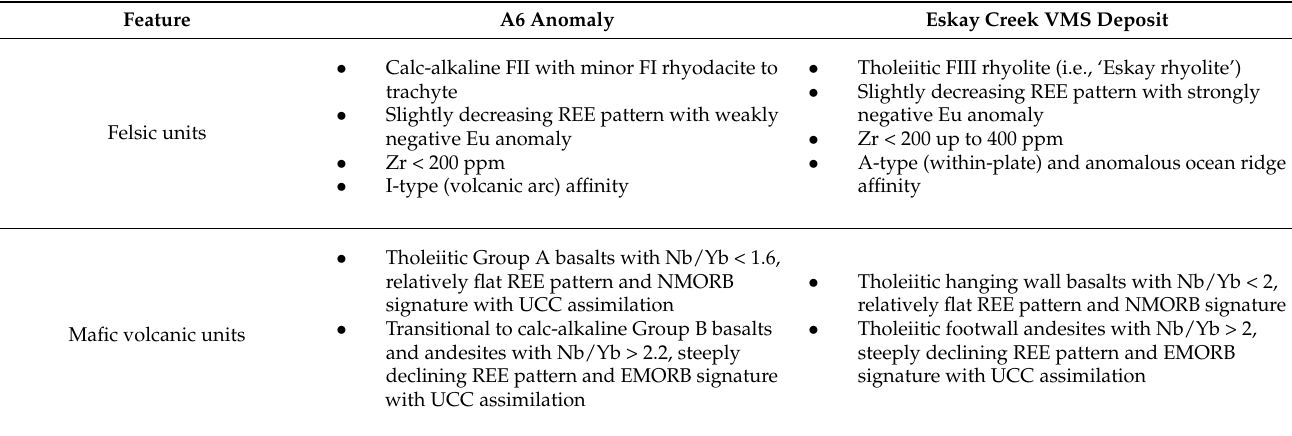
Table 5. Comparison of selected features for A6 Anomaly and Eskay Creek deposit, compiled with information from this study and